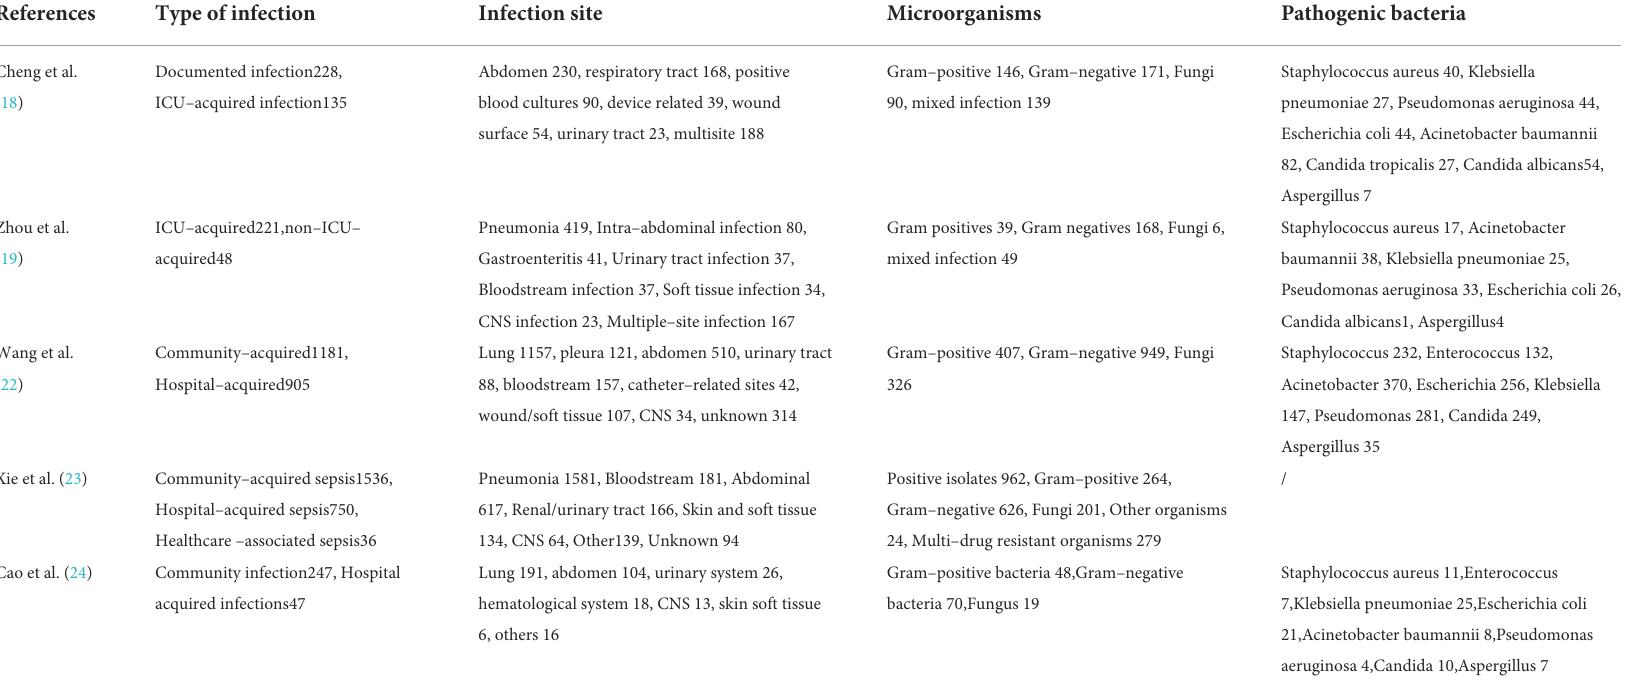
TABLE 3 Characteristics of infection in ICU patients included in the